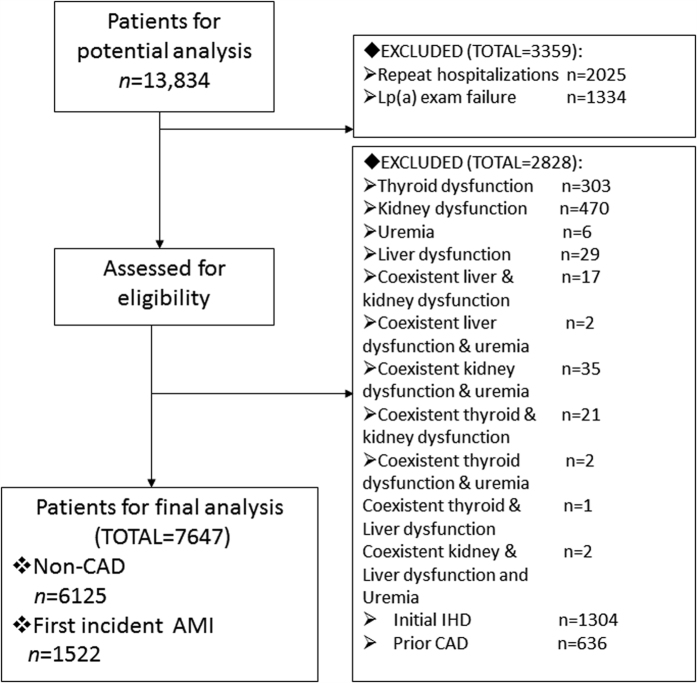
The flow chart of patient selection.